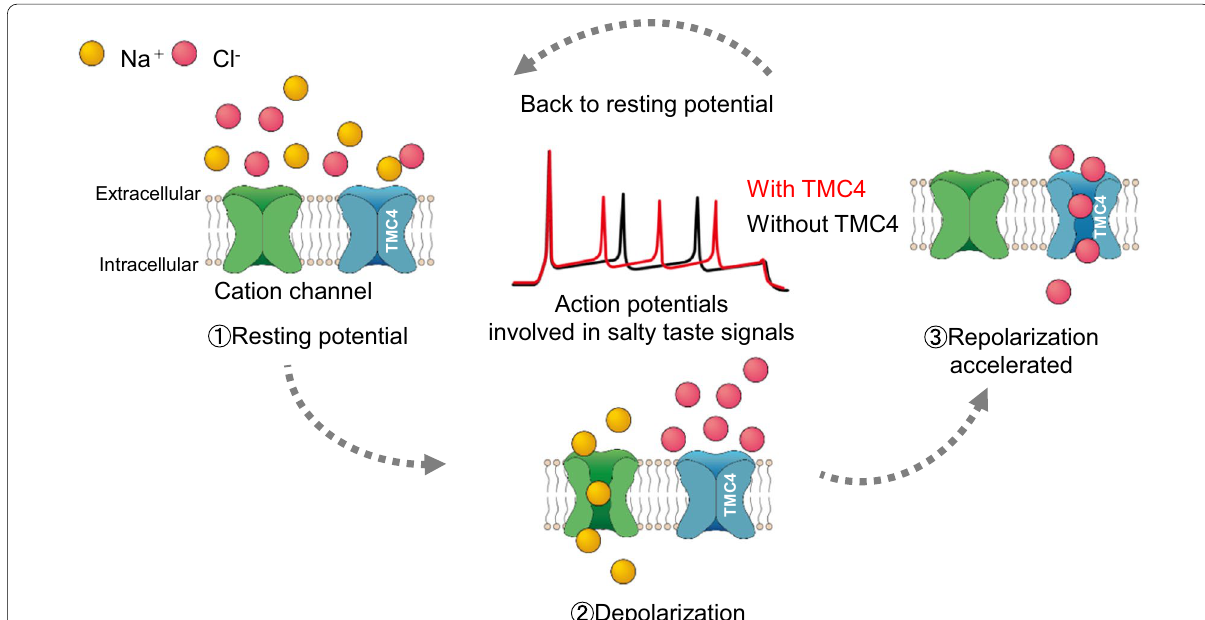
Fig. 2 Schematic representation of salt taste reception involving TMC4. The TMC4-expressing taste cell is not activated at the resting potential. Exposure of the taste cells to the stimulus of highly concentrated NaCl induces depolarization via the Na + influx through sodium or cation channels, which triggers an action potential generation for salt taste signals. Furthermore, this depolarization activates TMC4. After depolarization, Cl − fluxes into the taste cells through the TMC4, which helps the taste cells return to the resting potential. Consequently, TMC4 may accelerate the cycle of action potentials for salt taste signals. These processes facilitate neurotransmission via high-concentration salt taste cells, with the result that salt taste reception takes place through the glossopharyngeal